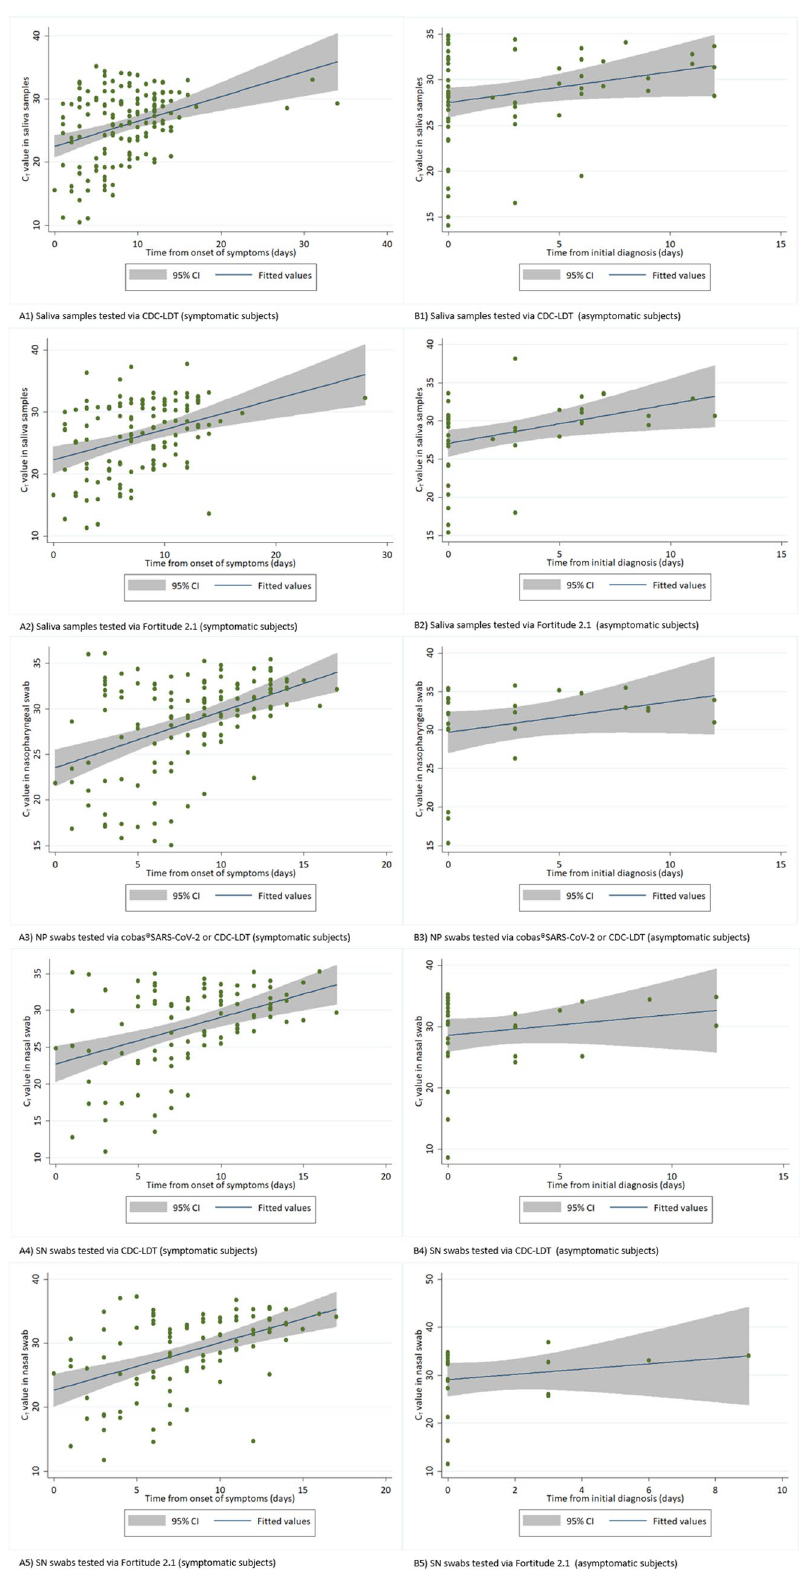
Figure 1. RT-PCR cycle threshold (Ct) values of naso-oropharyngeal saliva samples, nasopharyngeal (NP) swabs, and self- administered nasal (SN) swabs obtained from subjects infected with SARS-CoV-2. ( A ) (left) shows the cycle threshold (Ct) values of samples obtained from symptomatic subjects over time since the onset of symptoms. ( B ) (right) shows the Ct values of samples obtained from asymptomatic subjects over time since the initial COVID-19 diagnosis. Saliva samples and SN swabs were tested via CDC-LDT and Fortitude 2.1. All NP swabs were tested via cobas severe acute respiratory syndrome coronavirus 2 (SARS-CoV-2) (Roche Molecular Systems, Branchburg, NJ) or Centers for Disease Control and Prevention-Laboratory Developed Test